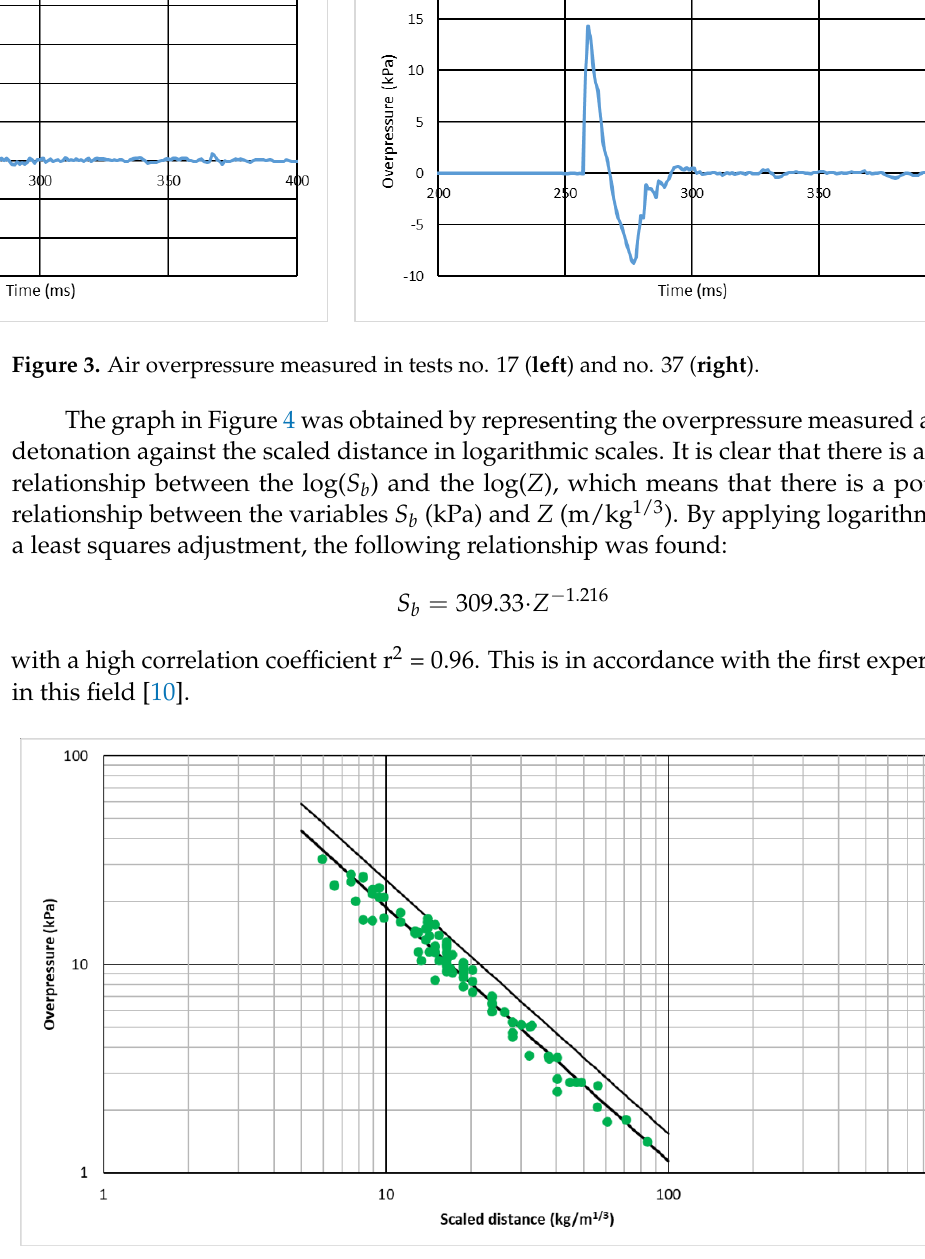
Figure 4. Air overpressure measured as a function of scaled distance with Riodin charges (dots are actual values while lower and upper lines correspond to Equation 3 and Equation 5 respectively) .